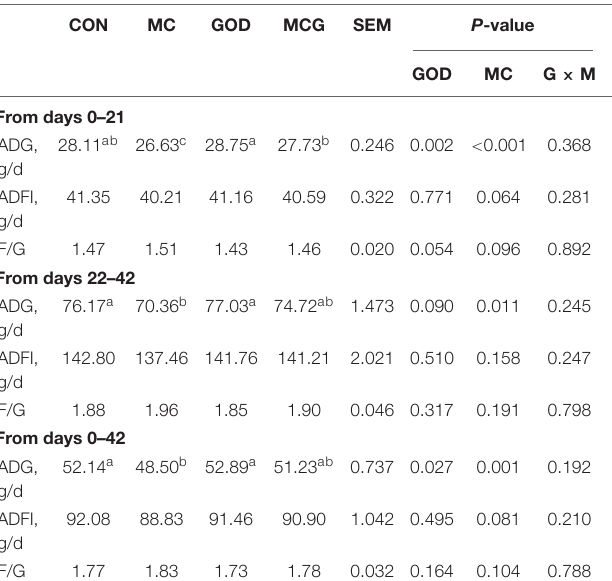
TABLE 3 | Growth performance of chickens.